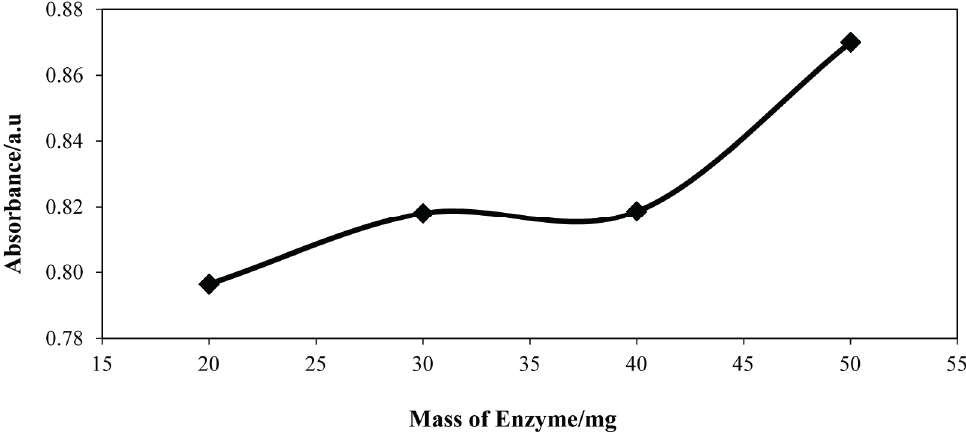
Figure 4. Absorbance spectra for FHA-V(V) complex after aminolysis of FFAs to FHAs using different amounts of enzyme. Crude palm oil, 6 mmol; hydroxylamine hydrochloride, 3 mmol; types of lipase; CAL-A, hexane, 3 mL; deionized H 2 O, 3 mL; V(V) ion solution, 300 µL; shaking rate, 150 rpm; reaction time, 50